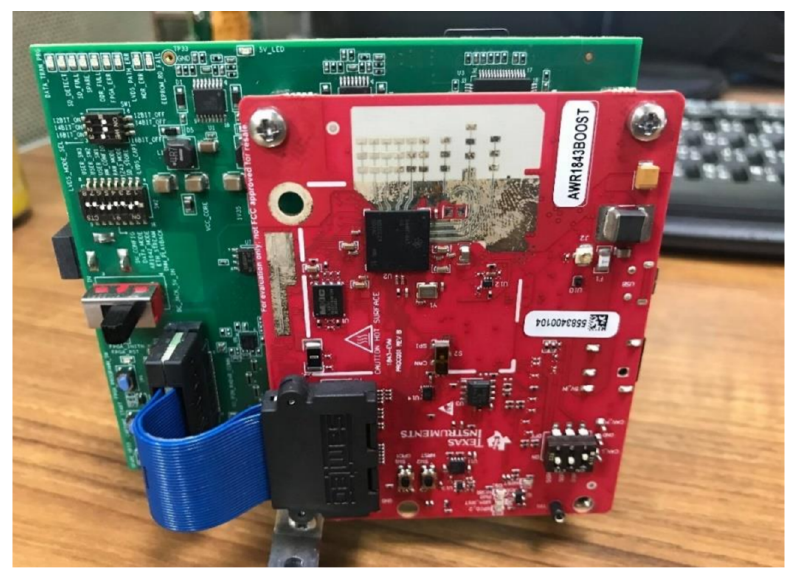
Figure 6. The photo of the actual radar used in experiments (AWR1843 and DCA1000EVM). Table 4. Experimental parameters.